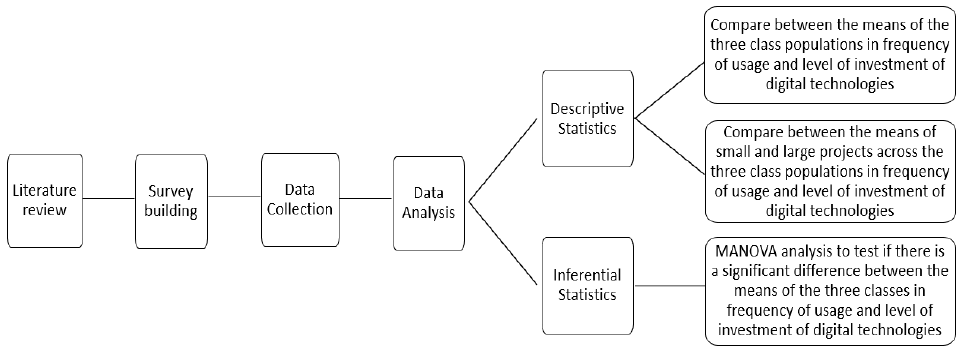
Figure 1. Methodology. Figure 1.